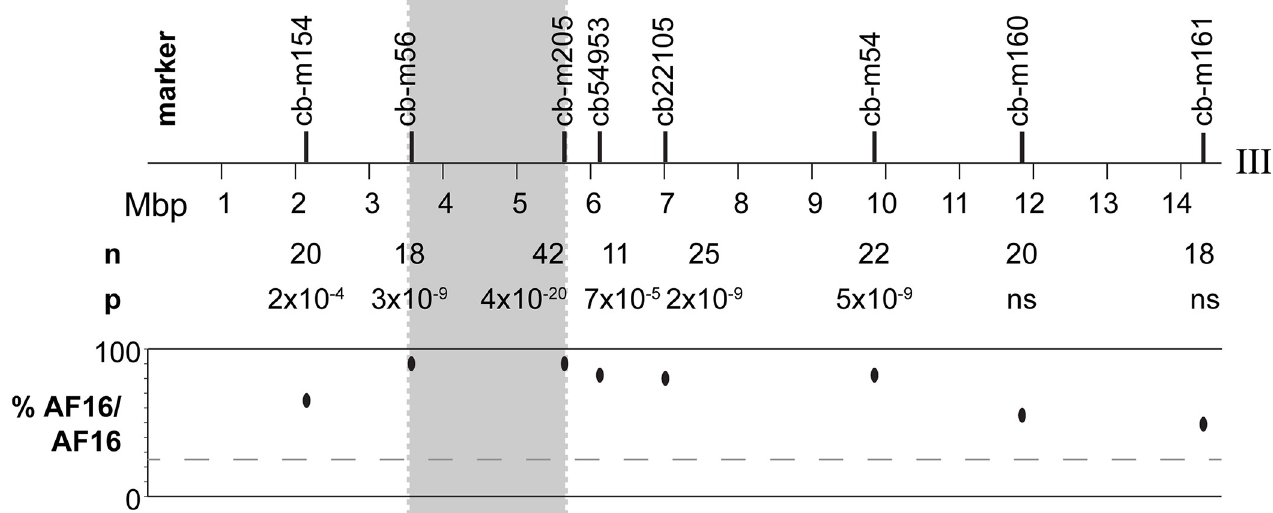
Fig 3. F2 genotypes across chromosome III. The percent of F2 genotypes homozygous AF16 at each marker in developmentally delayed F2 hybrids is plotted on the y-axis (“% AF16/AF16”). The total number of typed individuals (n) at each locus is provided above the plot, along with the p value (chi-square, Bonferroni-corrected) of the difference between expected and observed genotype values. “ns” indicates not significant p values. The gray line at 25% AF16 homozygosity denotes the Mendelian expectation for AF16 homozygosity in F2 hybrids. The gray shaded box indicates the two markers with maximum allele fraction